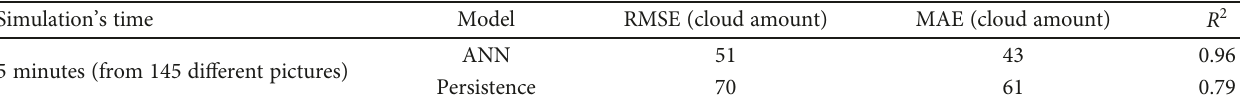
Table 2: Statistic indicator comparison between the new ANN forecast model and the persistence forecast model for the 50 manually selected pictures.